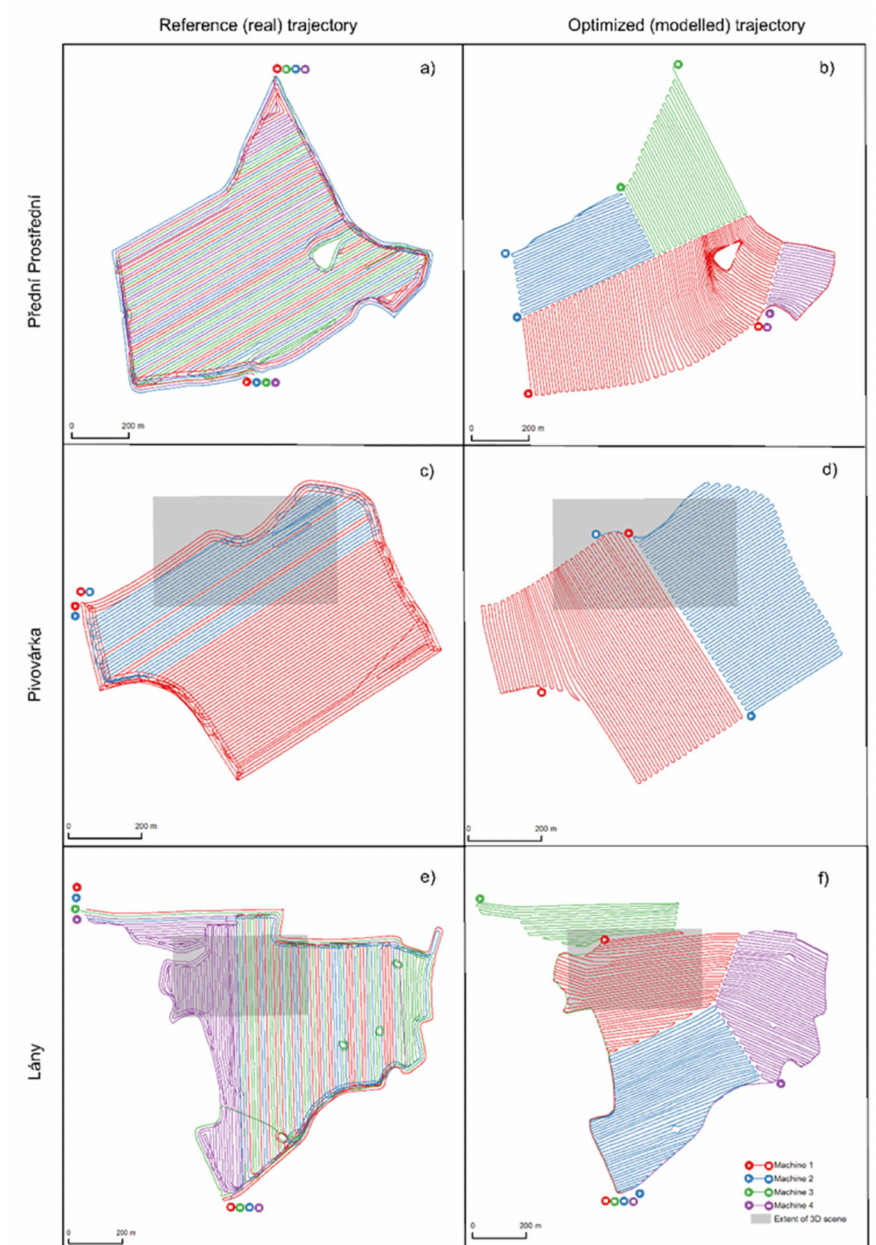
Figure 7. Map-based presentation of reference (real) trajectories measured at Rostˇenice Farm ( a , c , e ) and optimized (modeled) trajectories with an identical number of harvesting sequences ( b , d , f ). Table 3. Descriptive statistics: range of differences in trajectory length, elevation gain, and number